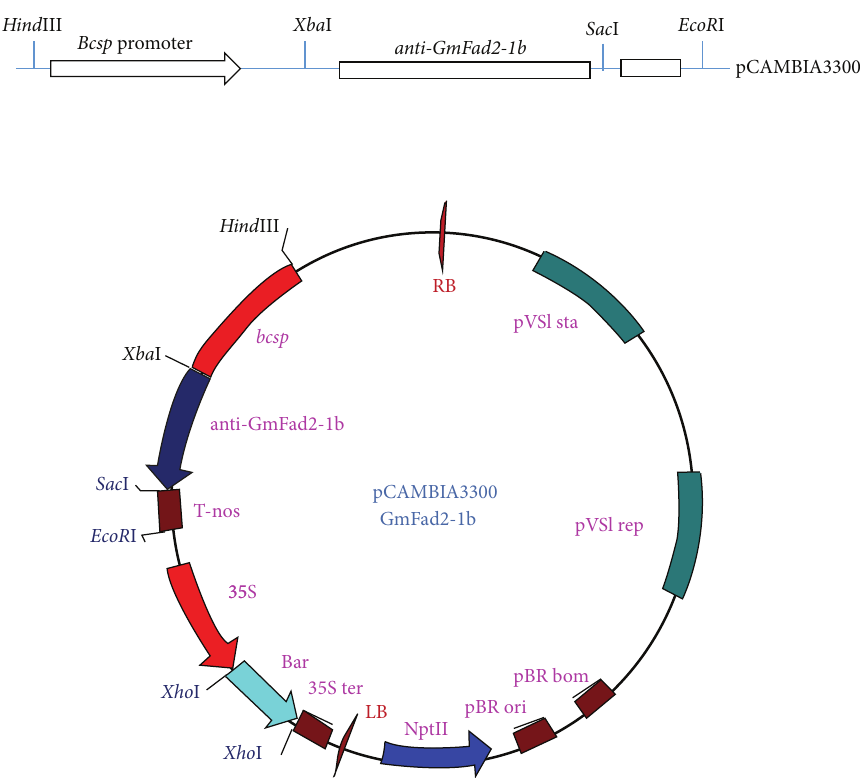
Figure 2: Map of vector pCmbia3300- Bcsp-GmFad2 . A schematic representation of the expression cassettes of the anti-GmFad2-1b and pCAMBIA3300 plasmids used for Agrobacterium -mediated transformation of soybean cotyledonary node. The anti-GmFad2-1b gene is under the control of the soybean seed promoter and 30 region